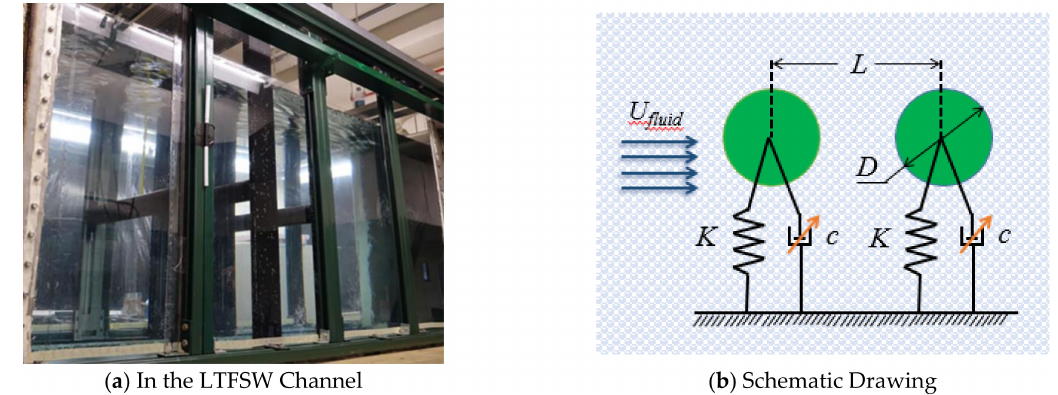
Figure 1. Two-cylinder VIVACE Converter with Vck: ( a ) In the LTFSW Channel; ( b ) Schematic